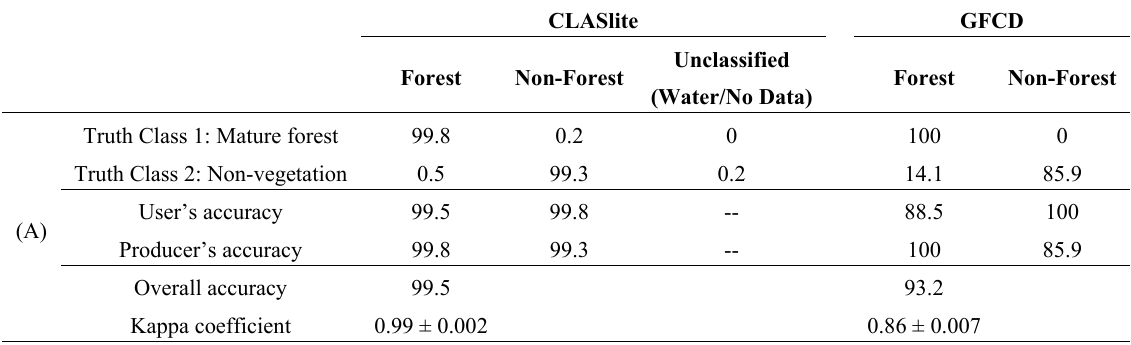
Table 2. Contingency matrices assessing the accuracy of two land-classification maps of Gola and its surrounding 25 km region in early 2001 derived by classification via the Carnegie Landsat Analysis System lite (CLASlite) and the Global Forest Change dataset (GFCD). Matrix A details the accuracy assessed when the two land-cover classes of mature forest and non-vegetatio n are used as truth classes against each of the two land-cover classes of the derived classification maps. Matrix B details the accuracy assessed when the two land-cover classes of mature forest and other vegetation are used as truth classes. Values in the “Truth Class” rows represent percentage of total pixels in the truth class classified as a given land-cover type on the derived maps, with 2960 total pixels identified in the mature forest truth class, 2776 total pixels in the non-vegetation truth class, and 2522 total pixels in the other vegetation class. All accuracy values are presented as percentages. Kappa coefficients are reported ± one standard error. Cells containing dashes instead of numeric values indicate values that were not considered in accuracy